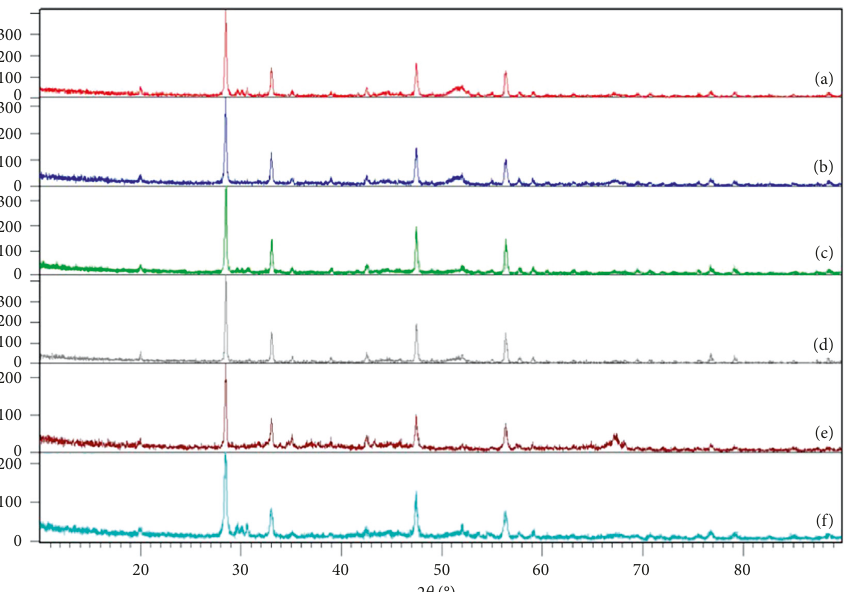
Figure 1: X-ray diffraction patterns of selected products gained from solid-state reactions using various ratios of precursors (nGd 3+ /mAl 3+ ) after irradiation at different conditions. (a) 0.3 Gd 3+ /0.7 Al 3+ at 1000 ° C for 10h, benzyl alcohol + SDS (sodium dodecyl sulfate); (b) 0.3 Gd 3+ / 0.7 Al 3+ at 1000 ° C for 10h, benzyl alcohol + oleic acid; (c) 0.5 Gd 3+ /0.5 Al 3+ at 1000 ° C for 10h, benzyl alcohol + SDS; (d) 0.5 Gd 3+ /0.5 Al 3+ at 1000 ° C for 10 h, benzyl alcohol + oleic acid; (e) 0.1 Gd 3+ /0.9 Al 3+ at 1000 ° C for 10 h, benzyl alcohol + oleic acid; (f) 0.3 Gd 3+ /0.7 Al 3+ at 800 ° C for 10h, benzyl alcohol + SDS.